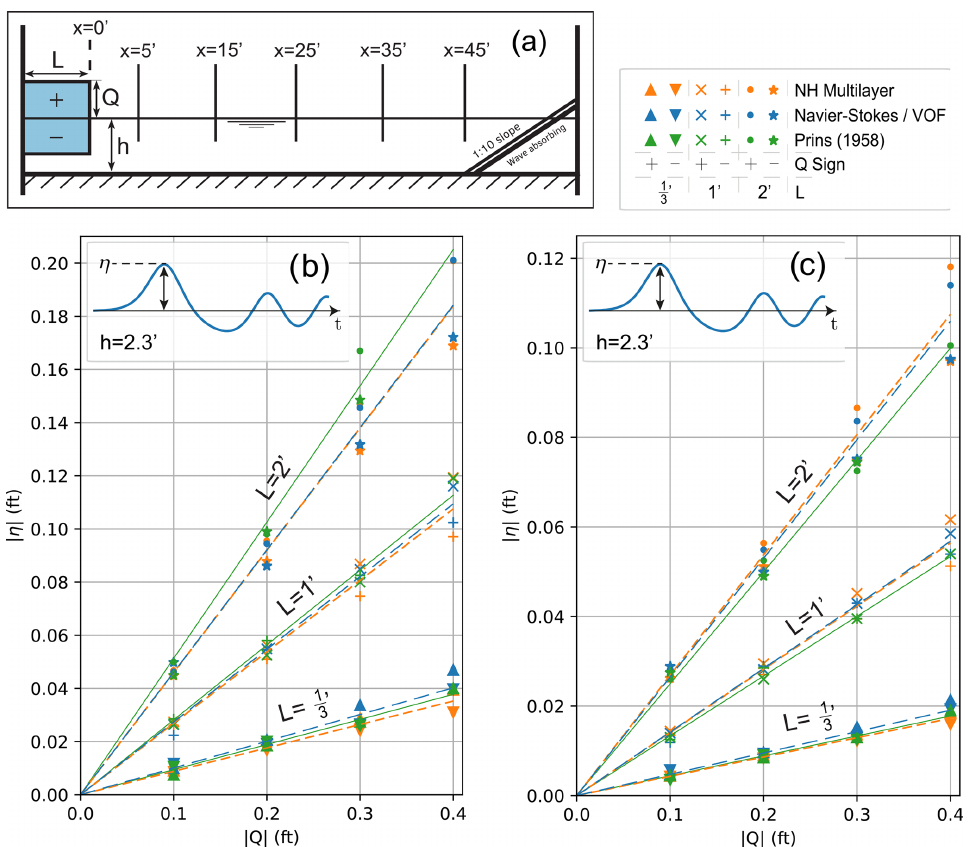
Figure 2. (a) Schematic diagram of the experimental set-up of Prins (1958), with gauge locations and the initial disturbance. (b) η – Q relation for first arrival crest or trough amplitude at x = 5ft. (c) η – Q relation for first arrival crest or trough amplitude at x = 25ft. Regression lines through origin are plotted for each L -model combination. For approximate metric conversion of feet to metres, divide by